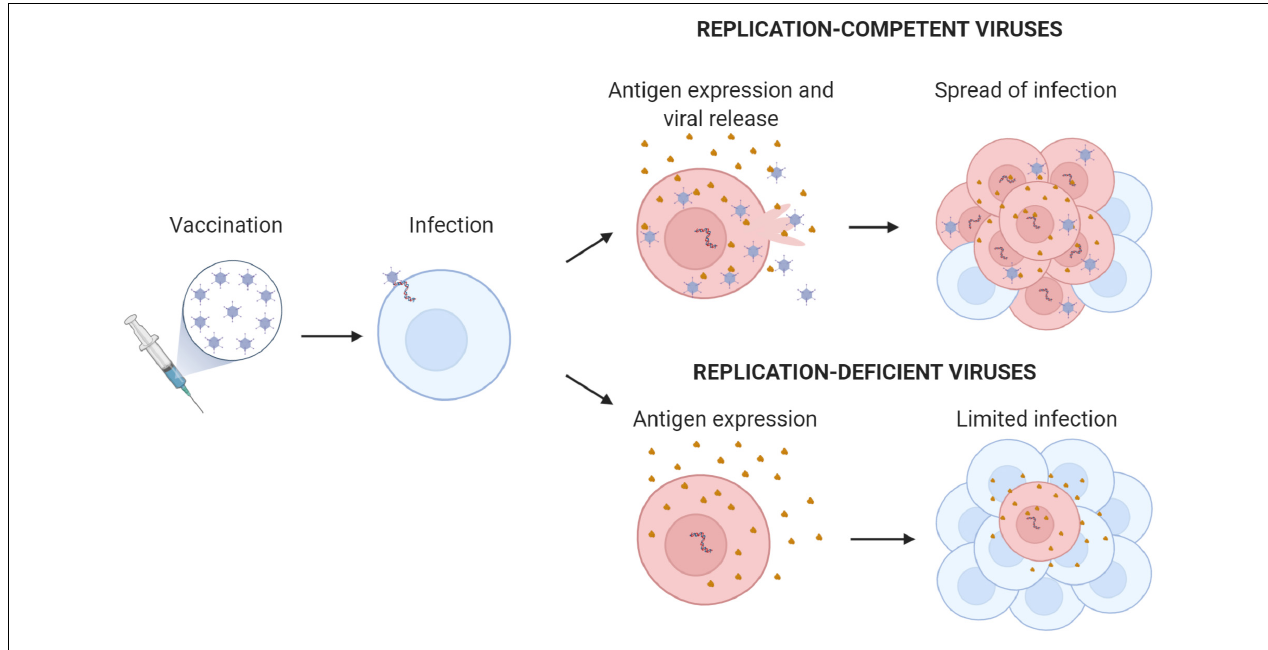
FIGURE 3 | Replication-competent versus replication-deficient adenovirus encoding transgenic antigen. The scheme illustrates the amplification effect of replication-competent adenovirus with the generation of new virions and increased antigen production. Antigen expressed from the adenovirus is shown in